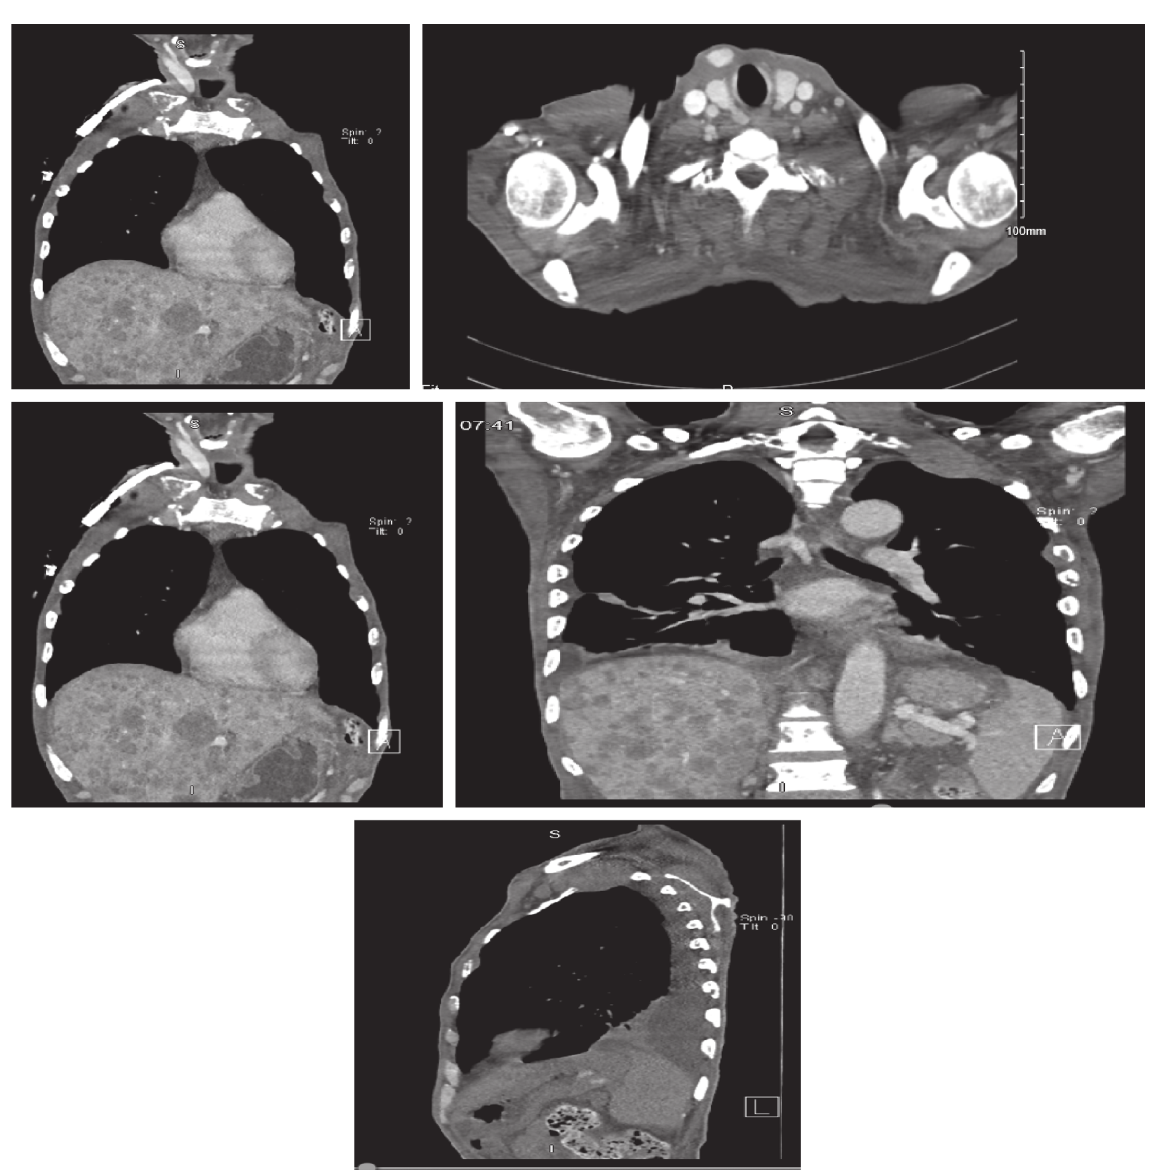
Figure 1: Images of the chest CT scan showing metastasis to the liver and chest